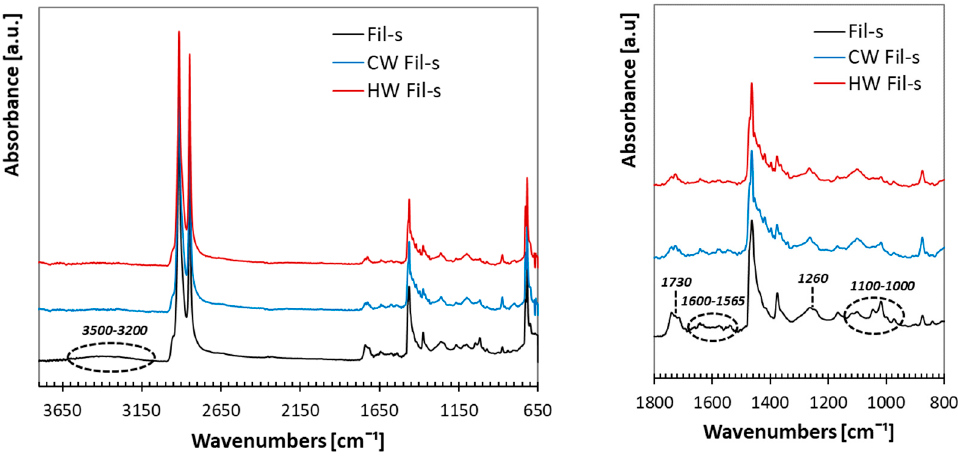
Figure 1. Comparison between the FTIR/ATR spectra of Cold Washed, Hot Washed and unwashed Fil-s. The peaks highlighted in the spectrum of Fil-s denote the presence of polar groups.